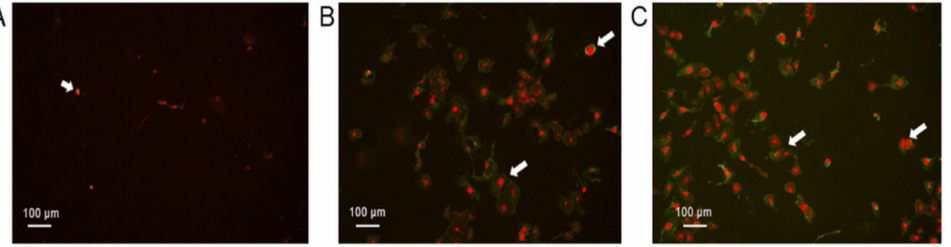
Figure 3. The SKOV-3 cells processed with annexin-V and propidium iodide after treatment with K. daigremontiana water extract. The cells were stained with annexin-V-fluorescein (green) and PI (red) after treating the cells with K. daigremontiana extract at concentrations of 0 µ g/mL (( A )-control), 40 µ g/mL ( B ), and 70 µ g/mL ( C ). Arrows indicate the late apoptotic or necrotic cells